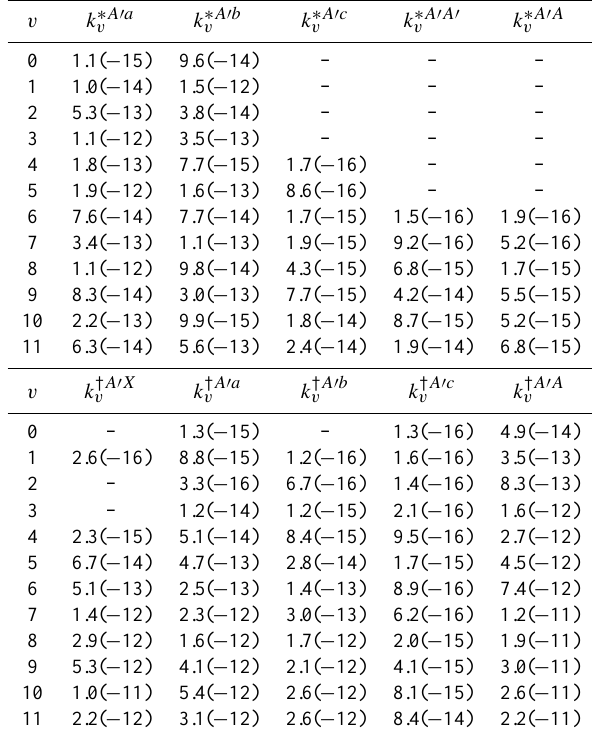
Table 1. Applied rate coefficients in Eq. (10c). Table 2. Applied rate coefficients in Eq.